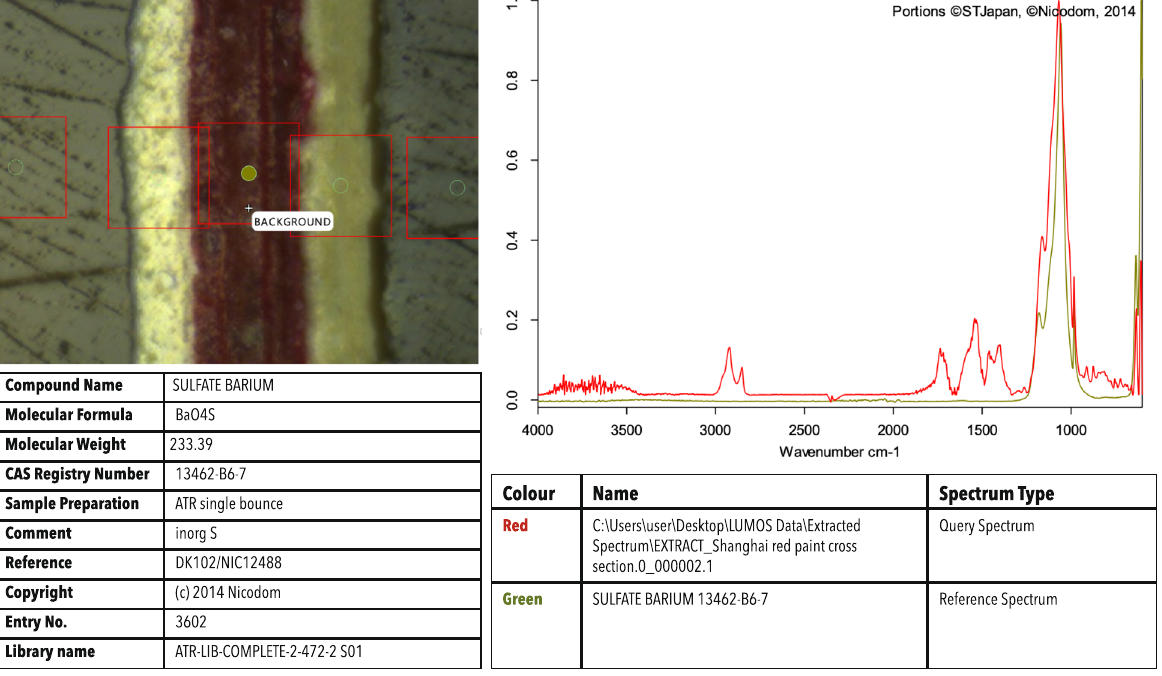
Fig. 12 FTIR ATR point measurement of a red paint cross section and example reference showing that the paint contains barium sulfate (most likely included as a filler). (Source: preliminary FTIR analysis of samples collected by the author, analysis conducted at the Architectural Conservation Laboratory at The University of Hong Kong, Alison Trachet)